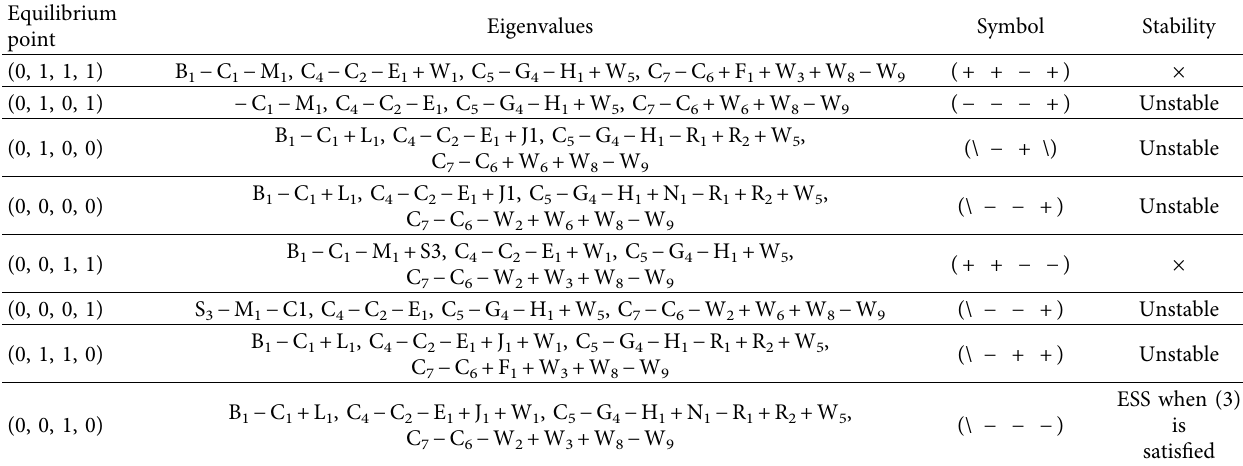
Table 3: Analysis of the stability of the system when the government chooses not to give particular support. Equilibrium point